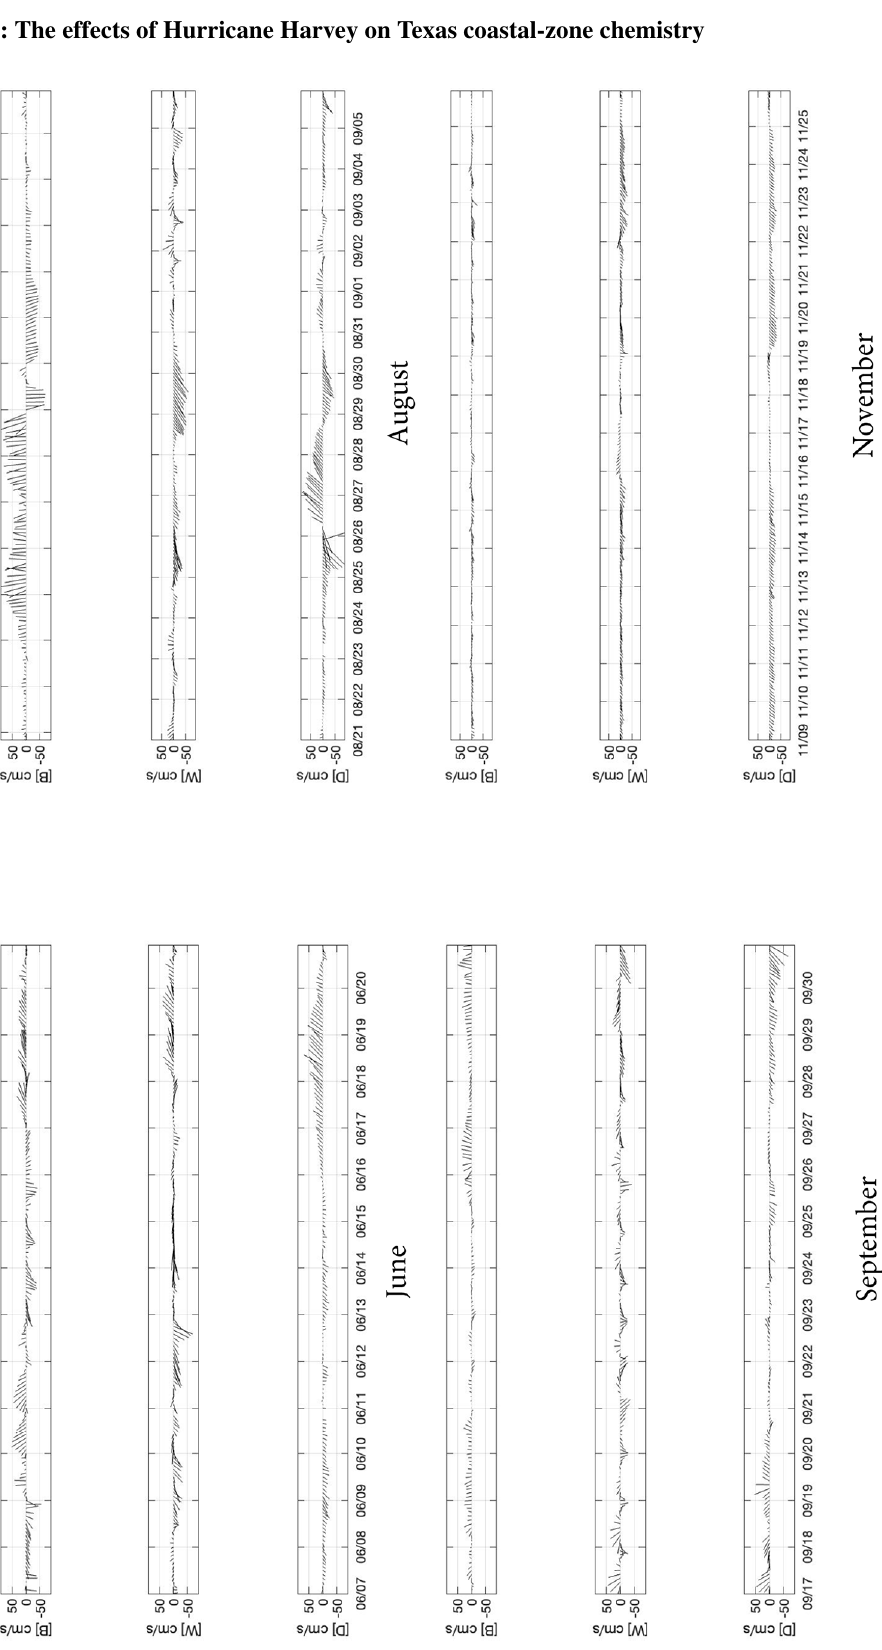
Figure 3. Current vectors at TABS buoys B, D and W during the cruise in June, the period of the hurricane (August), and the cruises in September and